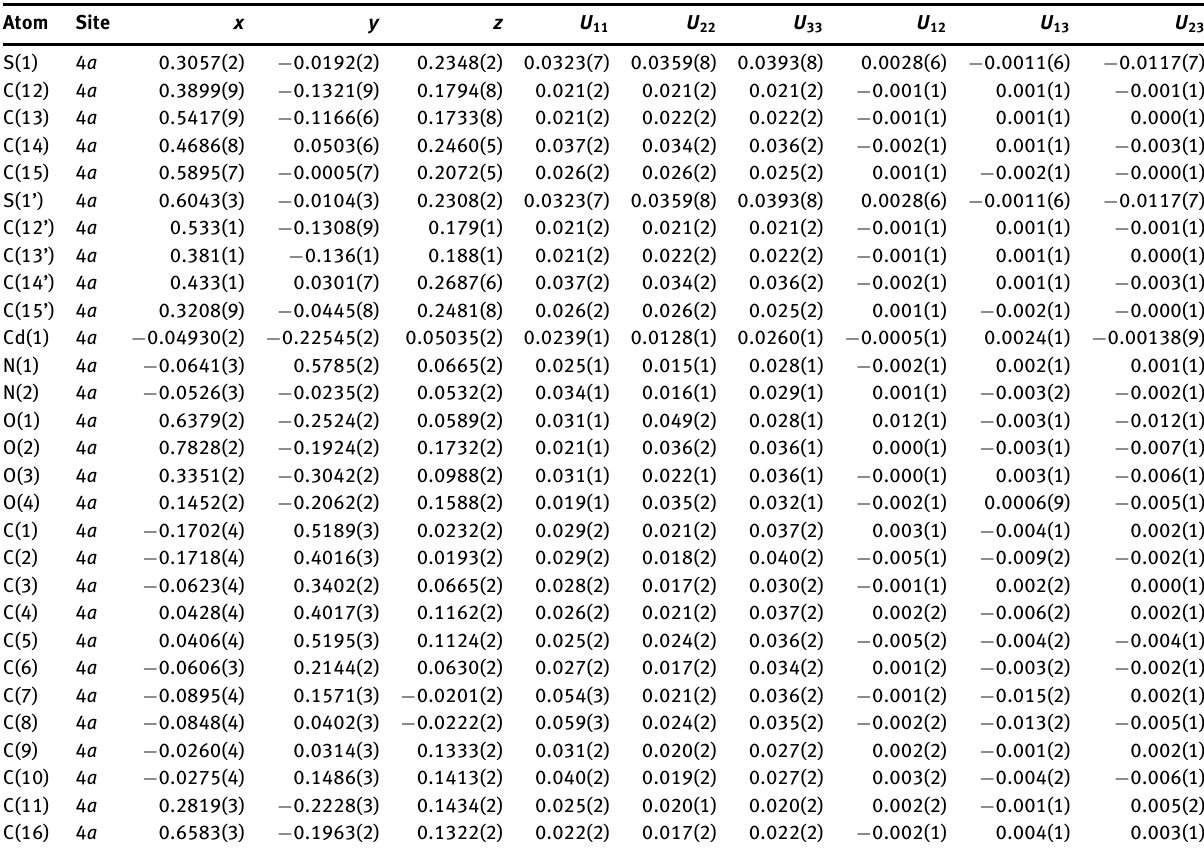
Table 3: Atomic displacement parameters (Å 2